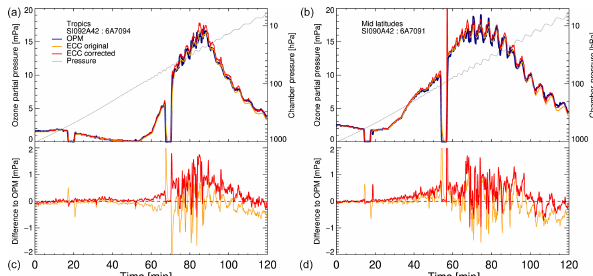
Figure 3. Reprocessing of JOSIE 2000 environmental simulation chamber ozonesonde data. (a) Tropical simulation, (b) midlatitude simulation. Blue lines in panels (a) and (b) : ozone photometer mea- surements. Orange lines: originally processed ozonesonde measure- ments. Red lines: reprocessed ozonesonde measurements using the separation of slow- and fast-reaction contribution. Thin gray line: chamber